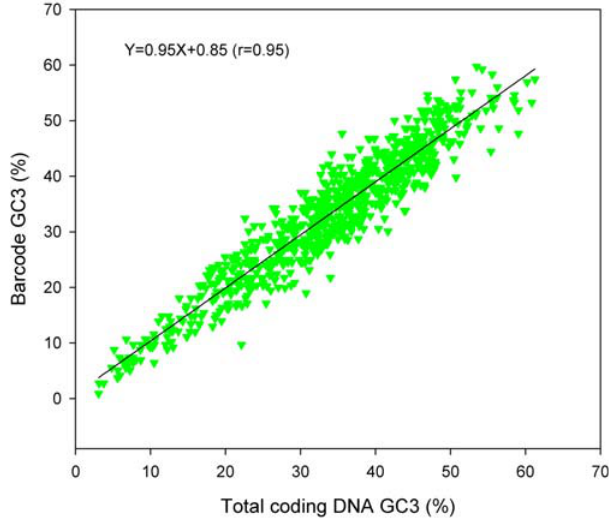
Figure 3. Correlation between GC content of the entire mitochondrial genome and the DNA barcode sequences. In this case, the nucleotide contents were calculated for the third codon position only.